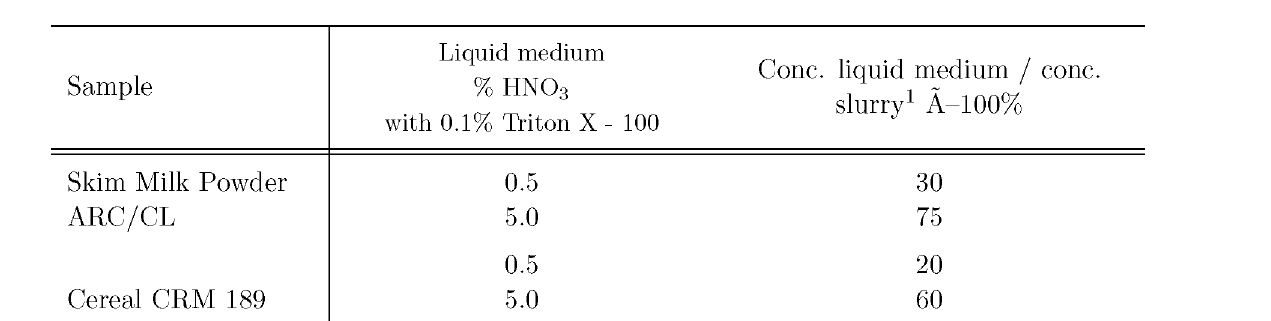
Table 2 Selenium partitioning in certified reference materials of infant